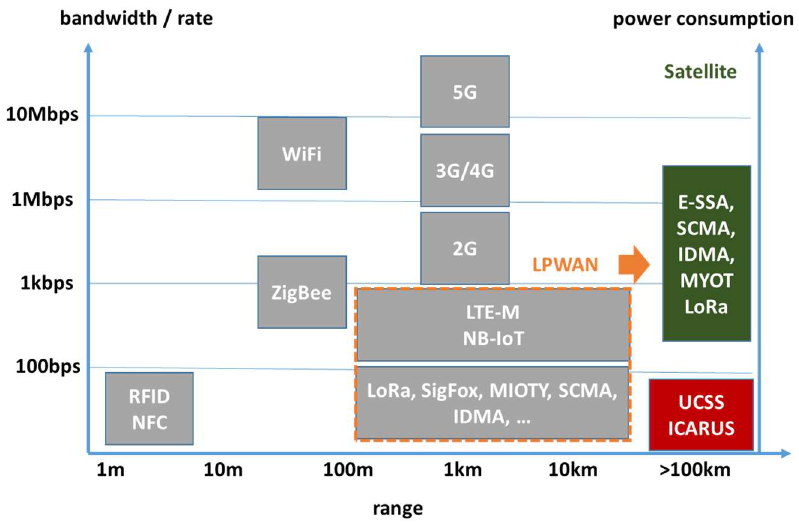
Figure 1. Taxonomy overview of satellite and non-satellite IoT systems .